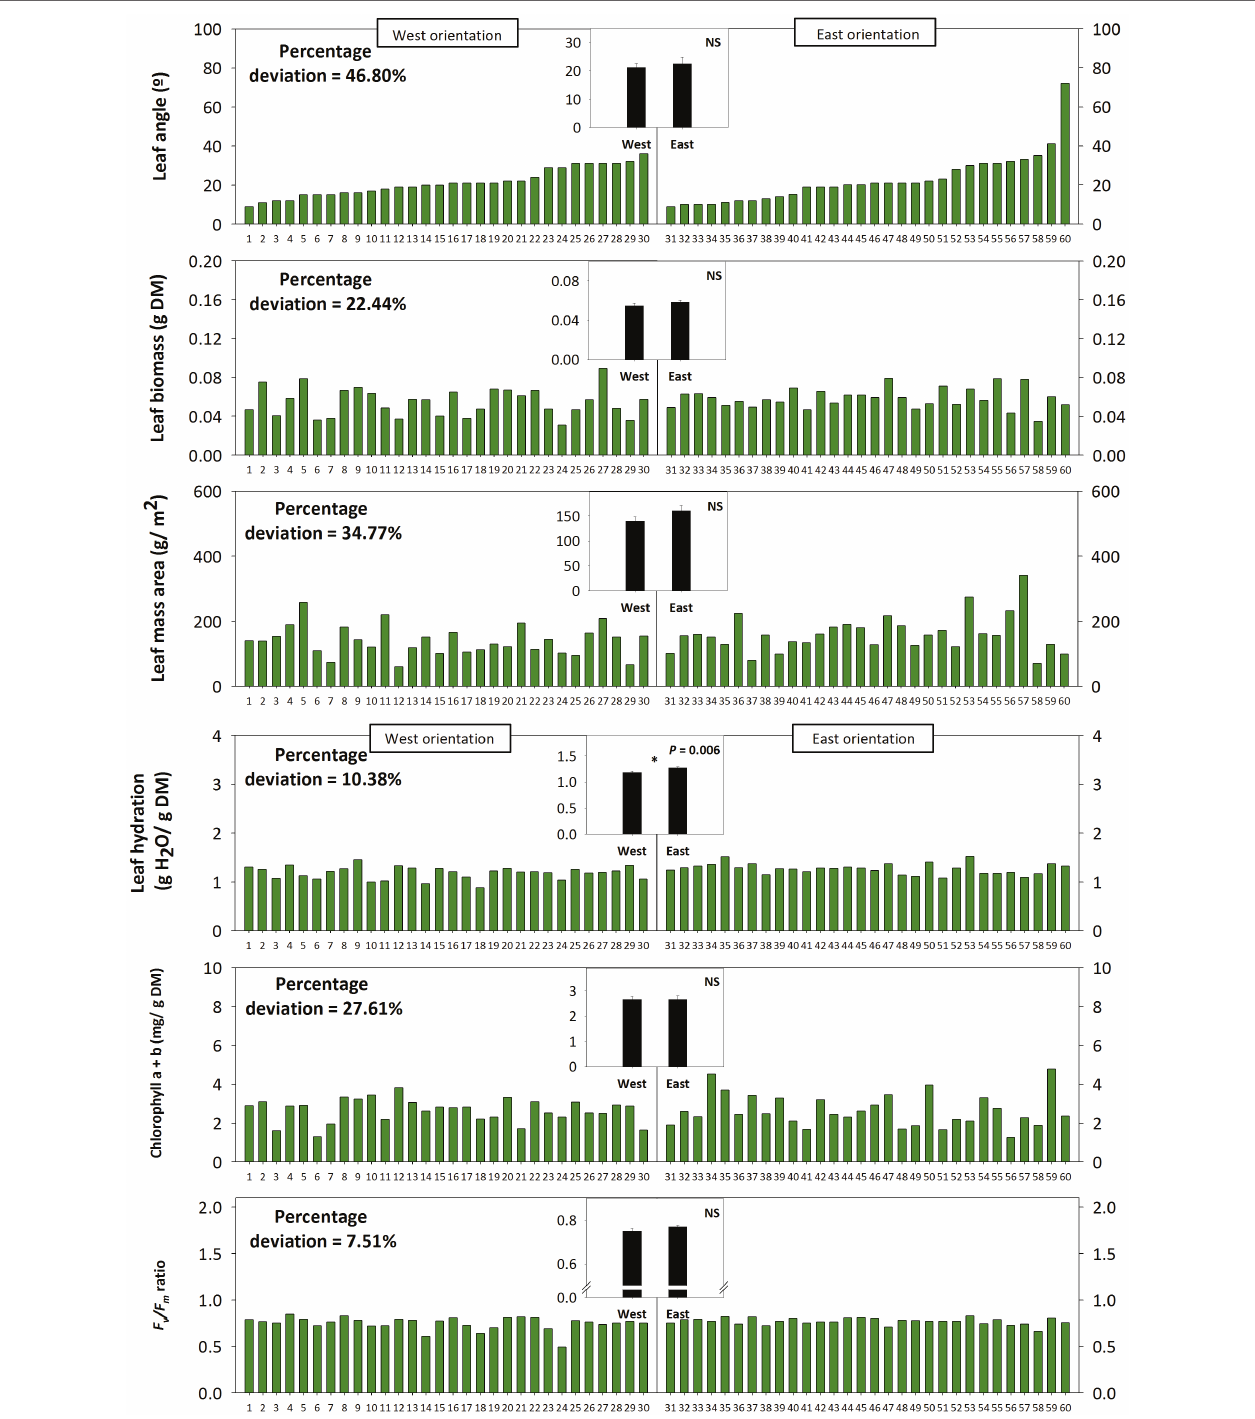
FIGURE 5 | Effects of sun orientation and inter-individual variability on leaf orientation in the Mediterranean shrub, C. albidus . A comparison between leaf angle, biomass, mass per area ratio, hydration, chlorophyll contents, and the F v / F m ratio in a C. albidus population growing at 1,100 m.a.s.l. in the Natural Park of the Montserrat Mountains with different sun orientation (East orientation, n = 30 individuals; West orientation, n = 30 individuals) during winter (22nd March 2018) is shown. Data correspond to leaf position 2 from the apex (see photograph in Figure 3 for details) for all studied individuals. The number of the individual (ordered from lower to higher leaf angle) is indicated in the x-axis. Percent deviation for every variable is given as (SD/Population mean) × 100, where SD corresponds to standard deviation. The mean ± SE for each sun orientation is shown in the graphs located in the inlets. Significant differences between groups were tested by a one-way analysis of variance (ANOVA, p ≤ 0.05) and indicated with an asterisk. NS, not